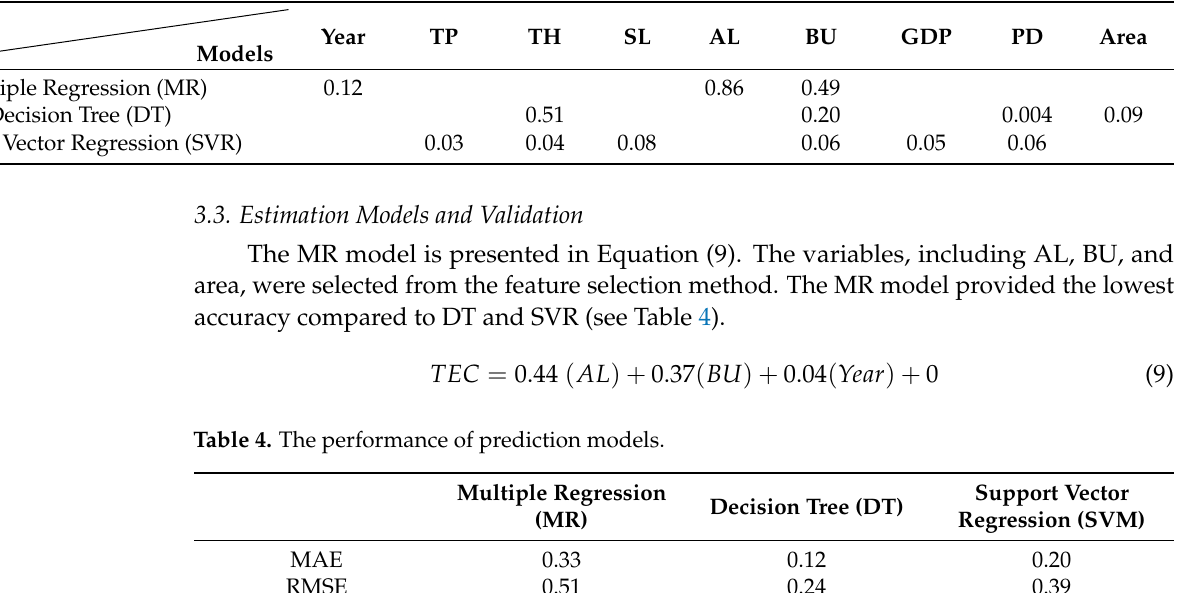
Figure 4. The scatter plot and correlation between predictors and prediction variable (sample of the year 2012 and 2018); ( a ) TEC and BU and ( b ) TEC and SL. Table 3. Electricity consumption estimation predictors and their weight in each model.